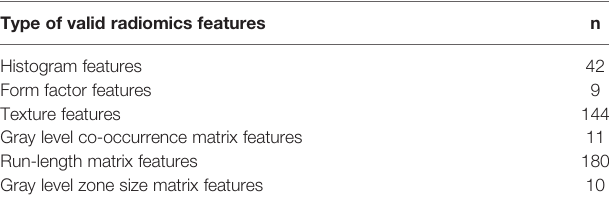
TABLE 2 | Types and numbers of valid radiomics